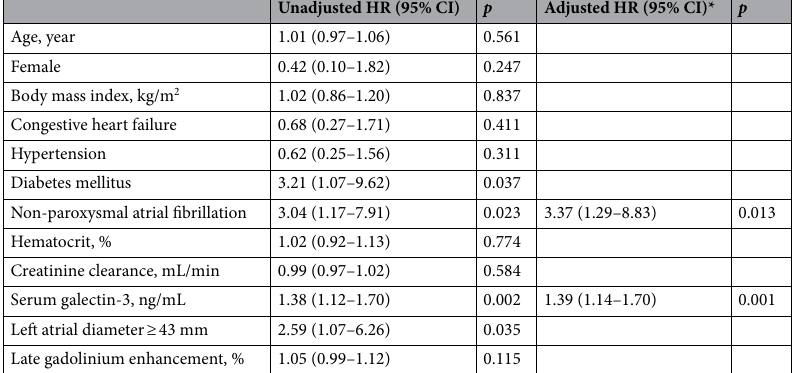
Table 2. Univariate and multivariable Cox regression analysis for recurrence after catheter ablation. *Adjusted for all covariates listed in the table using the Cox proportional hazards regression model with backward stepwise Wald elimination. CI confidence interval, HR hazard ratio.